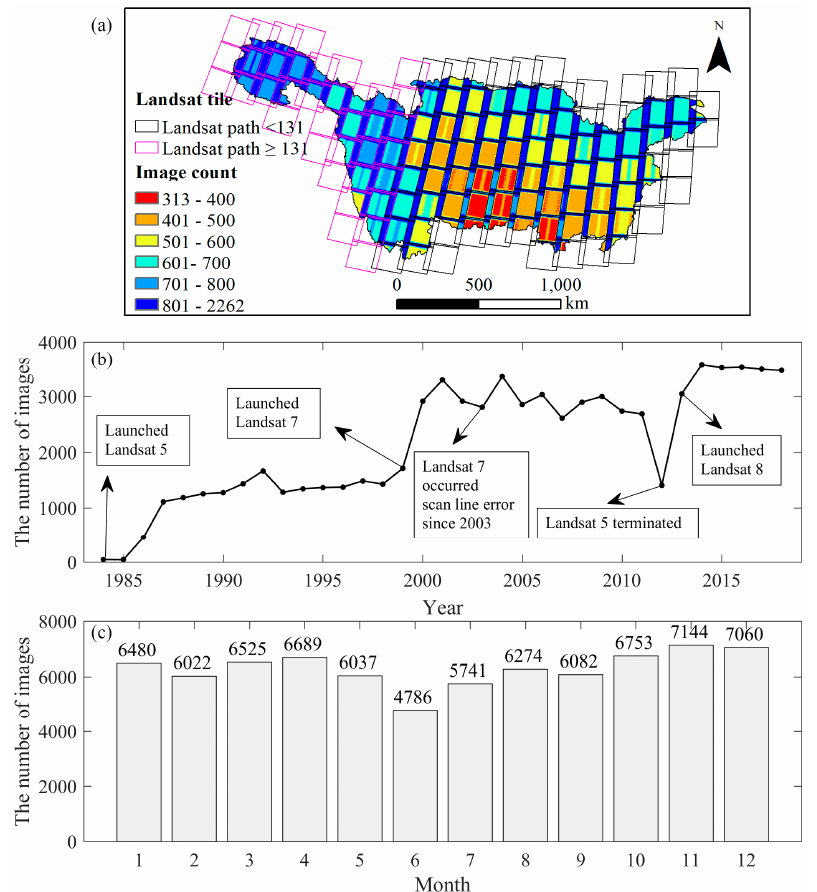
Figure 2. The Landsat image of the study area. ( a – c ) indicates the spatial distribution, temporal distribution, and seasonal